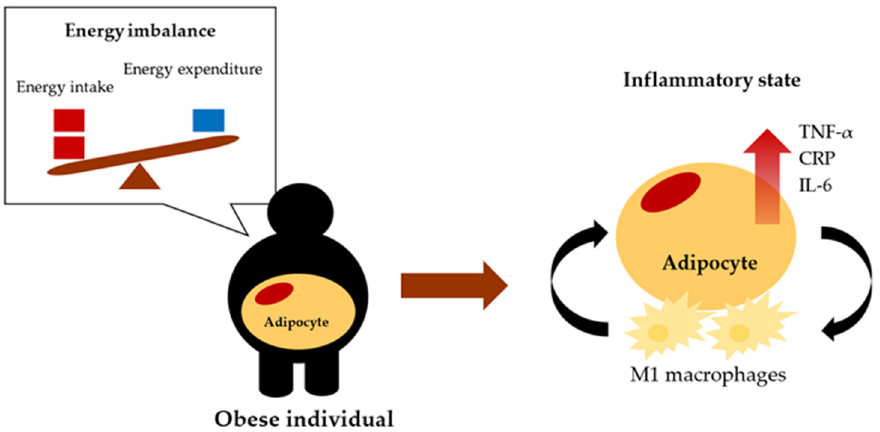
Figure 1. Hallmark of meta ‐ inflammation. The major cause of obesity is a positive energy balance between energy intake and energy expenditure leading to meta ‐ inflammation, a chronic low ‐ grade inflammatory condition.